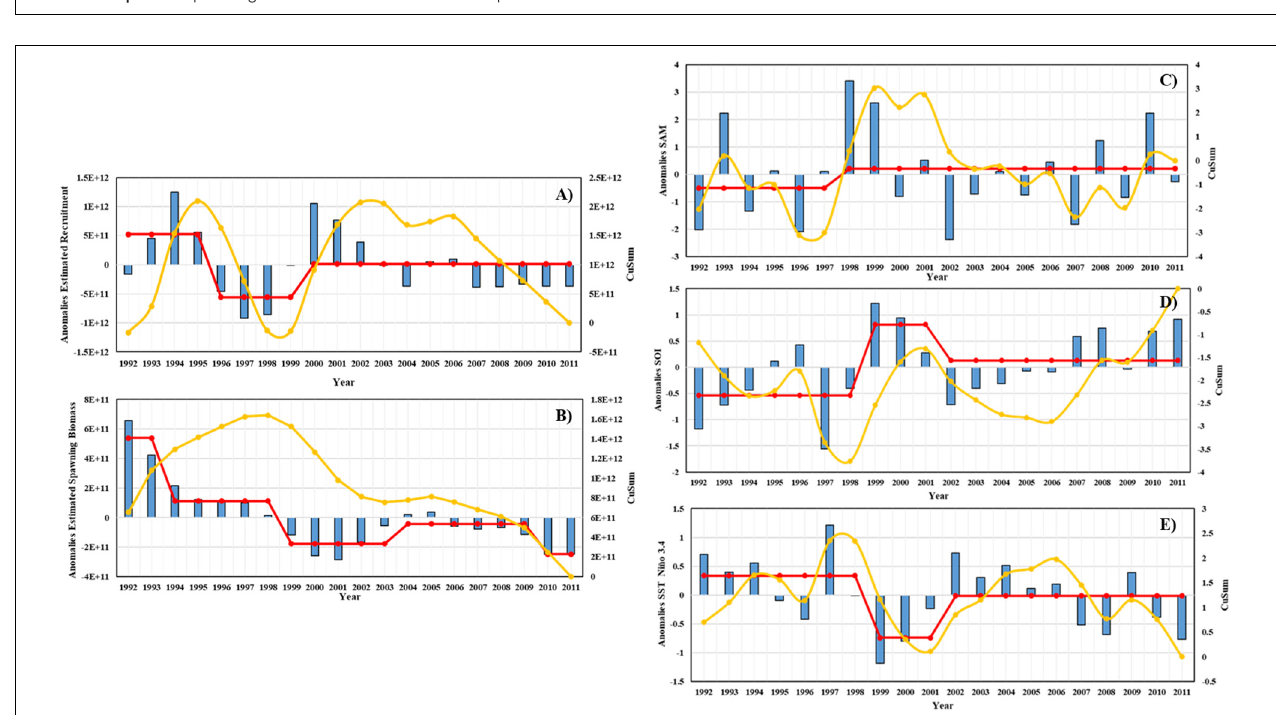
FIGURE 11 | Interannual variability of estimated Antarctic krill recruitment, spawning biomass and three climate indices. (A) Estimated recruitment, (B) Estimated spawning biomass, (C) SAM, (D) SOI, (E) SST in Nino 3.4. The histogram is the distance level, the yellow line is the cumulative, the red line is the steady-state transition obtained from the STARS